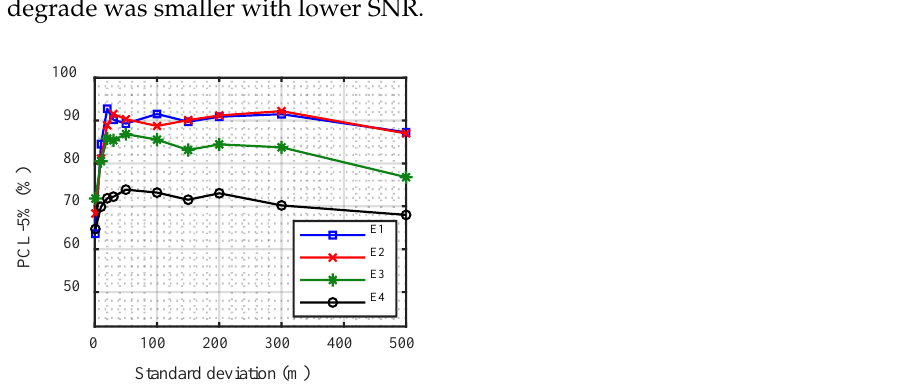
Figure 9. Performance of the modified convolutional neural network with different standard deviations.